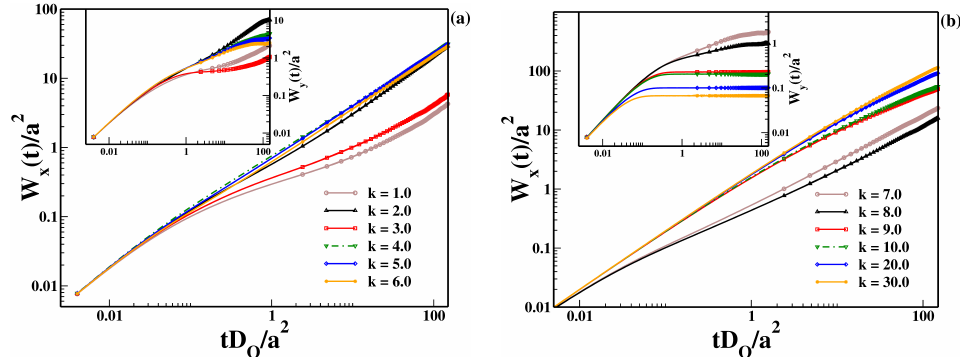
Figure 8. W x ( t ) for different values of the stiffness parameter, k , to cover intermediate and strong couplings. ( a ) 1 ≤ k ≤ 6; ( b ) 7 ≤ k ≤ 30 . Inset displays the MSDs in the y